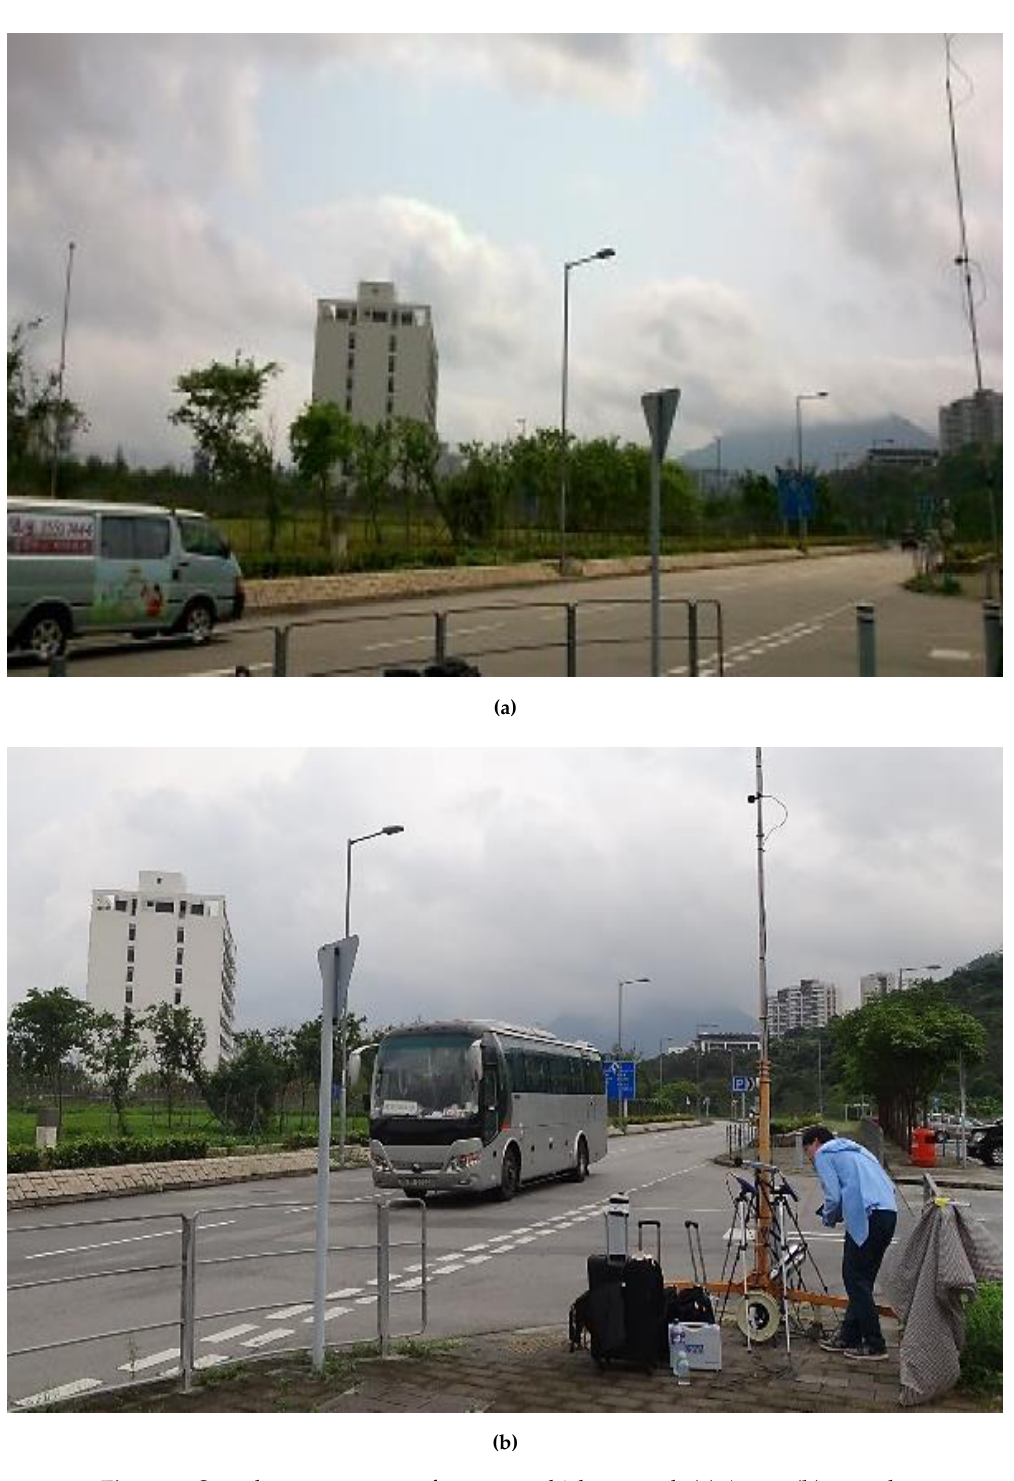
Figure 1. Sound measurements of a motor vehicle on road. ( a ) A van; ( b ) a coach.